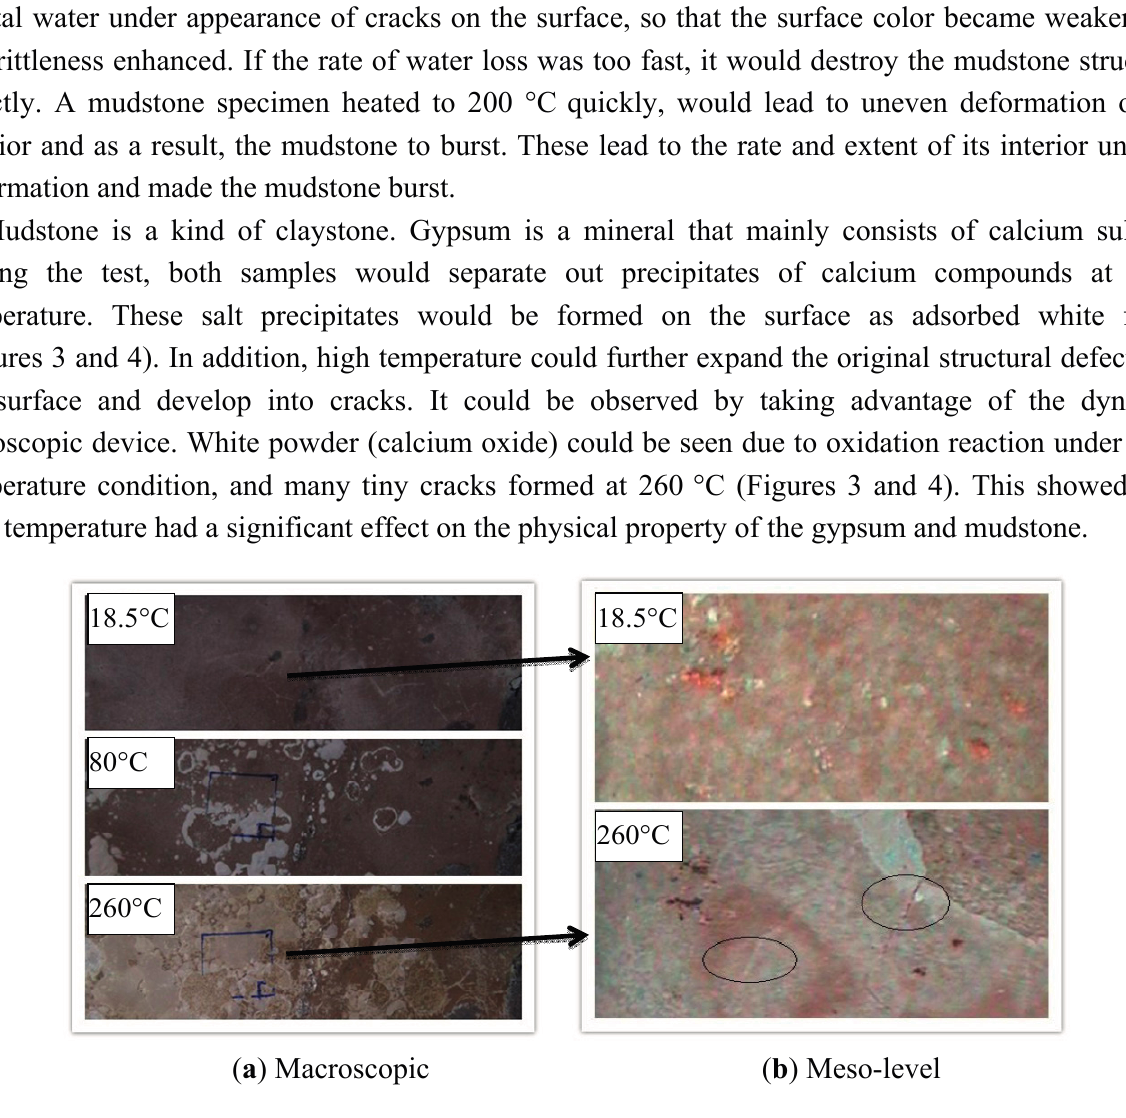
Figure 3. Thermal damage cracks of mudstone under high